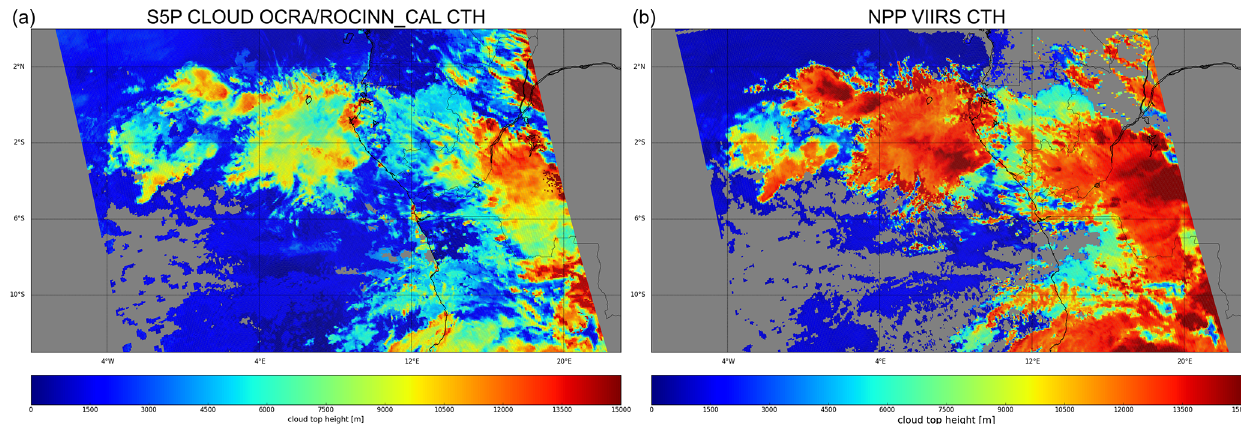
Figure 6. Panel (a) shows the cloud-top height of S5P OCRA/ROCINN_CAL processor version 1 for S5P orbit 01080. Panel (b) shows the corresponding cloud-top height of regridded NPP VIIRS.